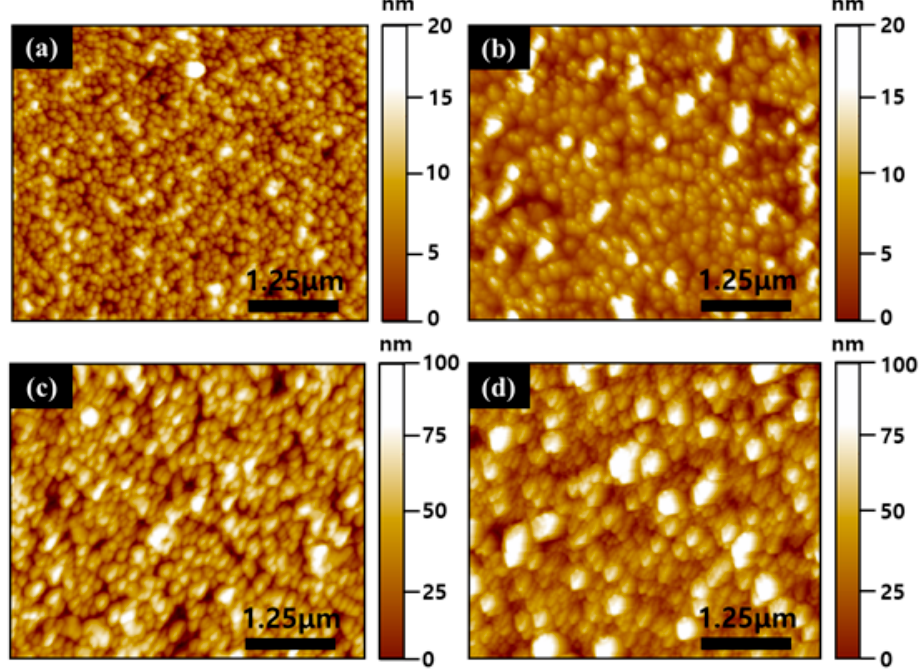
Figure 2. The atomic force microscopy (AFM) images of the ZnO films grown on LiNbO 3 before and after the etching. The surface-morphology images of the ZnO films grown on (+z) LiNbO 3 before the etching ( a ) and (-z) LiNbO 3 before the etching ( b ). ( c ). The surface-morphology images of the ZnO films grown on (+z) LiNbO 3 after the etching ( c ) and (-z) LiNbO 3 after the etching ( d ).